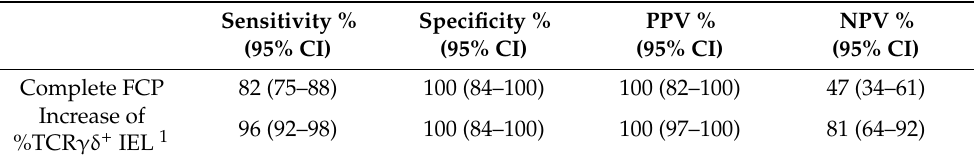
Table 5. Accuracy of coeliac cytometric pattern for the diagnosis of coeliac disease. Control group subjects with IEL count < 18% ( n = 27).